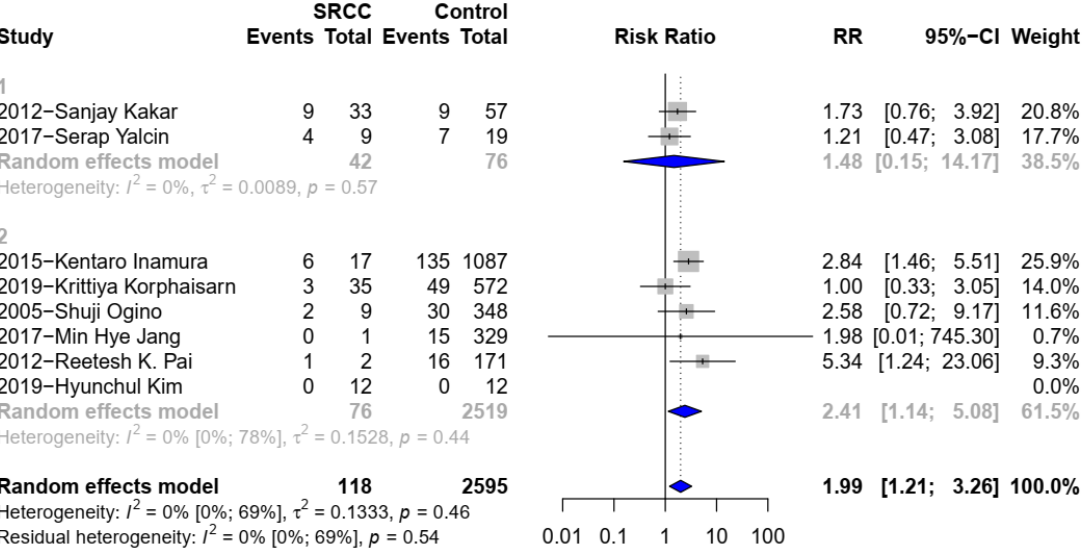
Figure 3. ( 1 ). Forest plot for BRAF between SRCC and non-SRCC (SRC component < 50% was not excluded). ( 2 ). Forest plot for BRAF between SRCC and C-CRC.